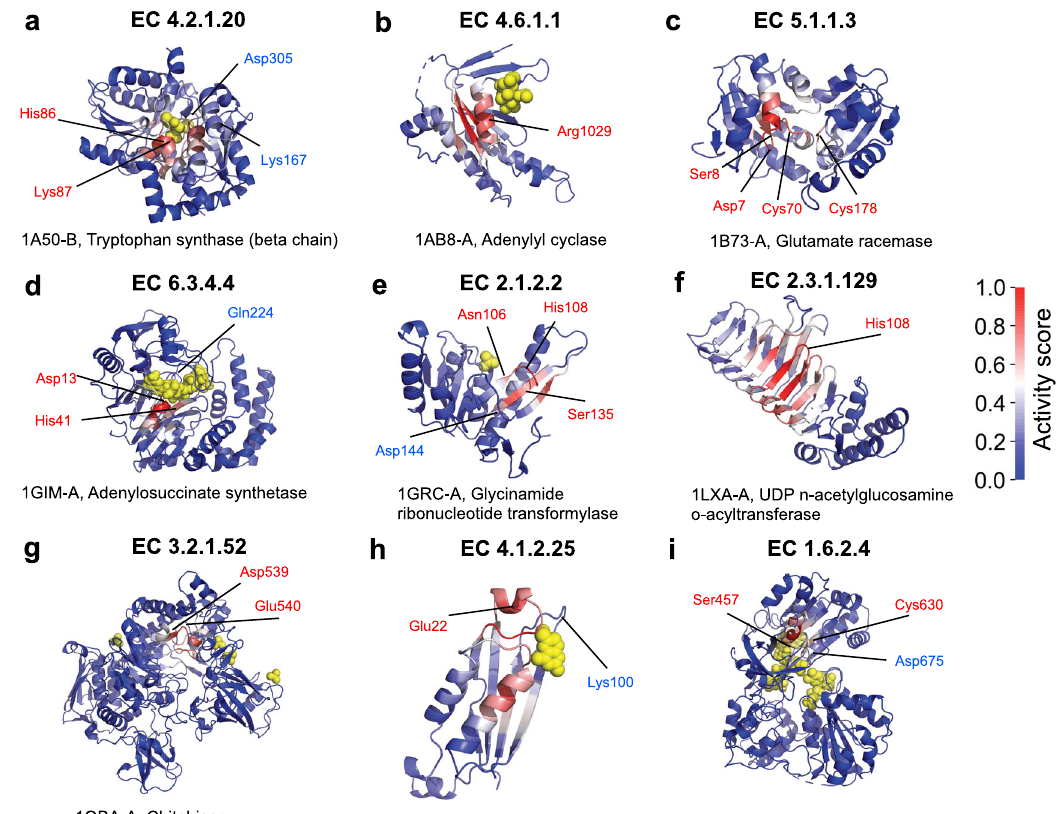
Fig. 5 Identifying catalytic residues in enzymes using grad-CAM applied on the DeepFRI model trained on EC numbers. All residues are colored using a gradient color scheme matching the grad-CAM activity score, with more salient residues highlighted in red and less salient residues highlighted in blue. The PDB chains (shown in panels a – i ) are annotated with all of its known catalytic residues (available in Catalytic Site Atlas), with a residue number and a pointer to the location on the structure. Residues correctly identi fi ed by our method are highlighted in